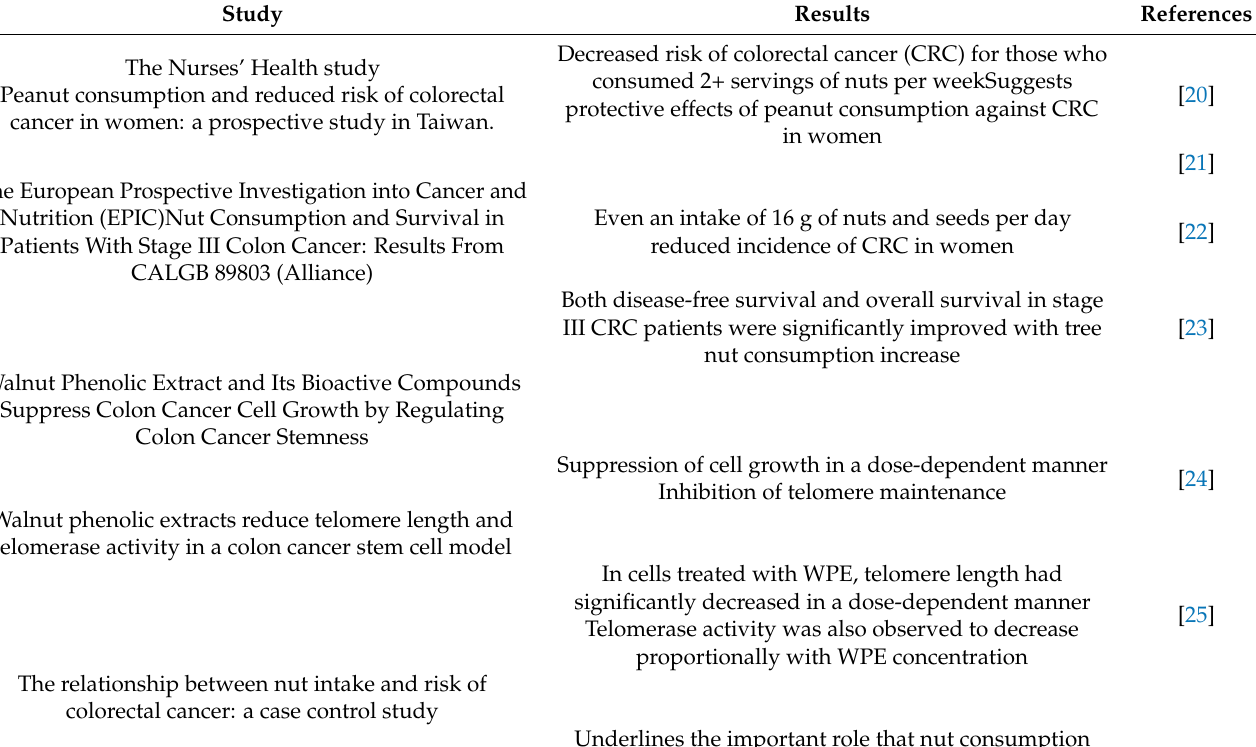
Table 2. Summary of study